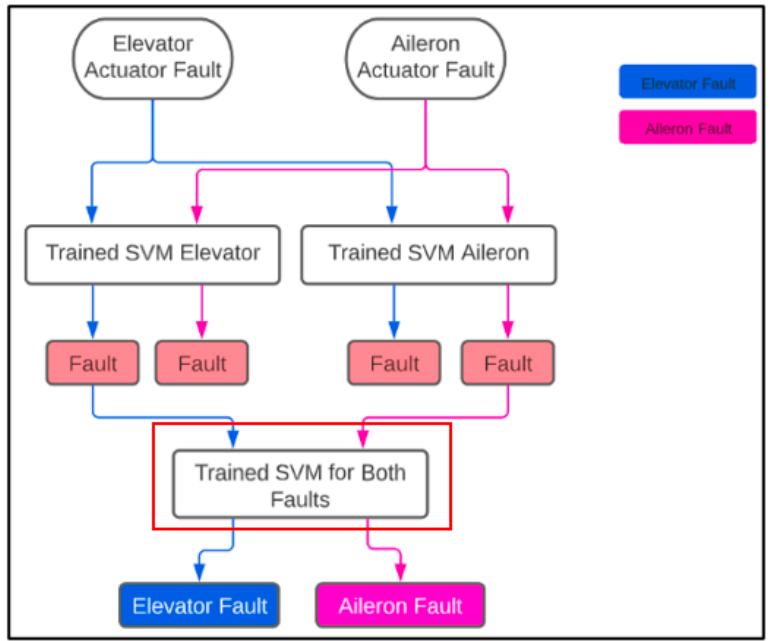
Figure 16. Addition of a SVM model that is trained for both elevator and actuator faults.